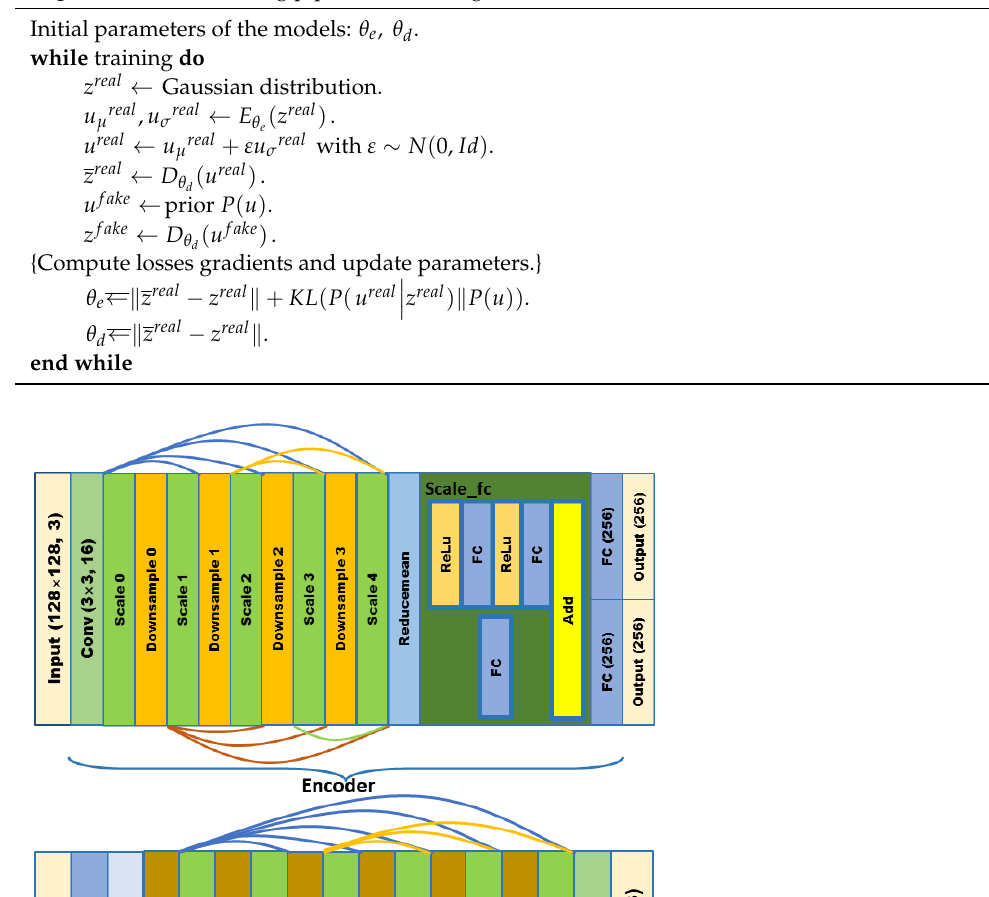
Algorithm 2: The training pipeline of the stage 2.